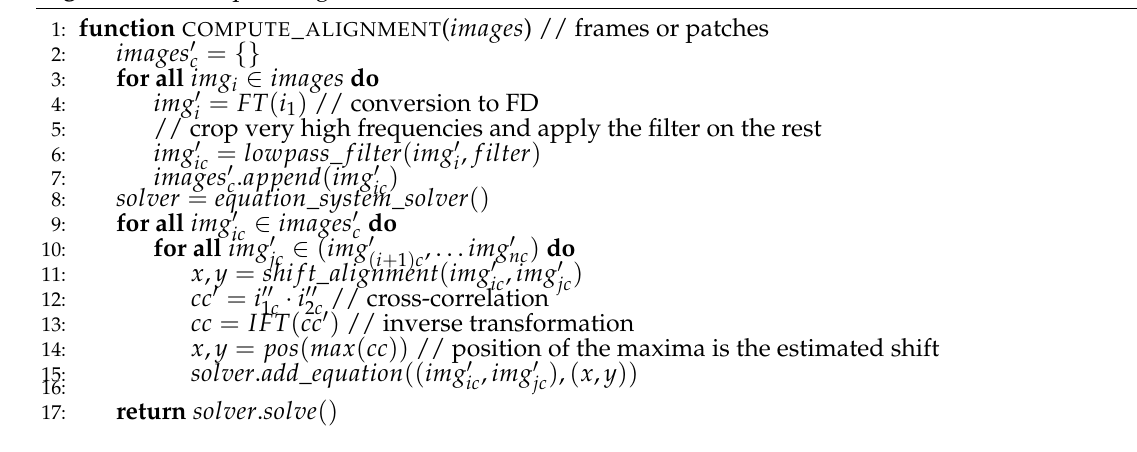
Figure 5. Flowchart of the core idea of the algorithm. Algorithm overview ( left ), alignment subroutine ( right ). Algorithm 1 Compute alignment